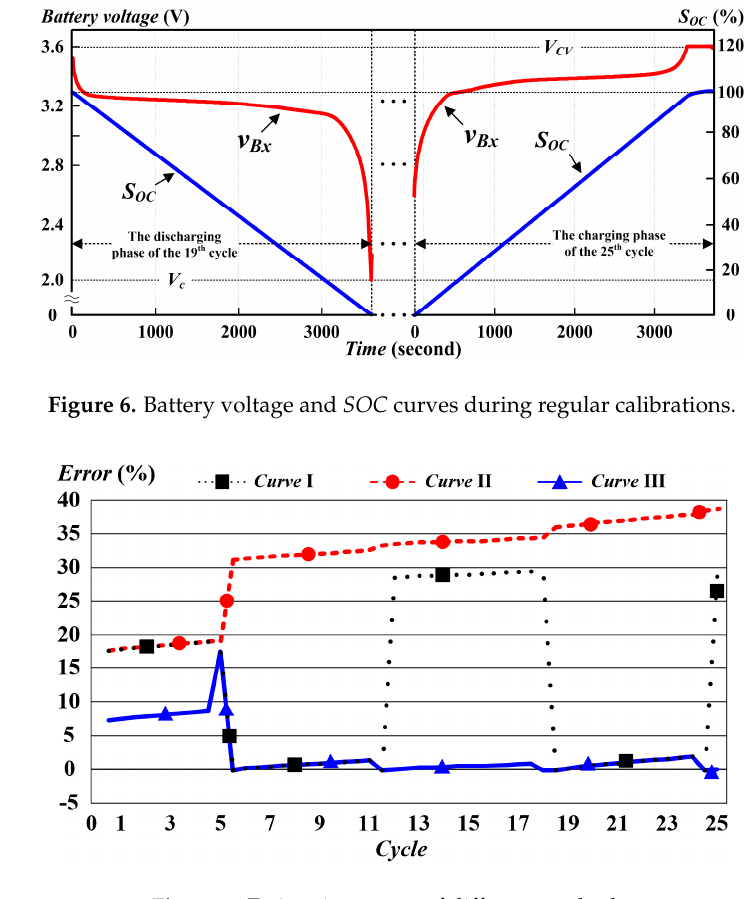
Figure 5. Battery voltage and SOC curves during partial calibration.